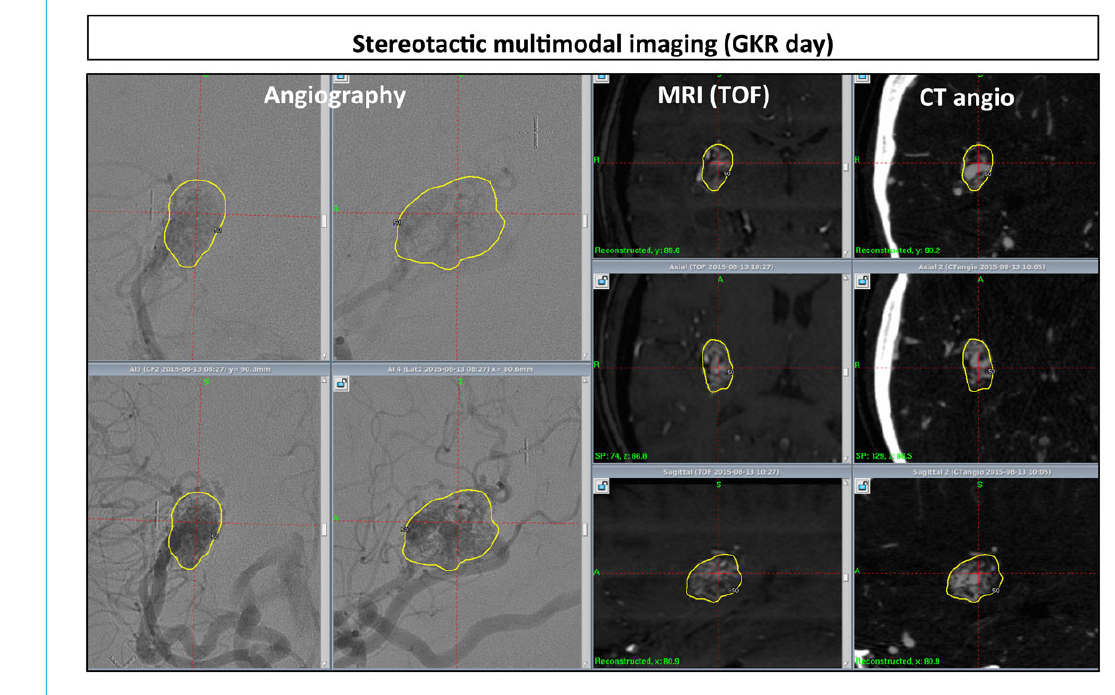
Figure 1: Example of multimodal imaging for gamma knife radiosurgery (GKR) purposes; all the MRI and CT examinations are done after stereotactic frame placement, the day of GKR; from left to right, DSA, MR time-of-flight (TOF) sequence and CT angiography (the former two in coronal-up, axial-middle, and sagittal-bottom